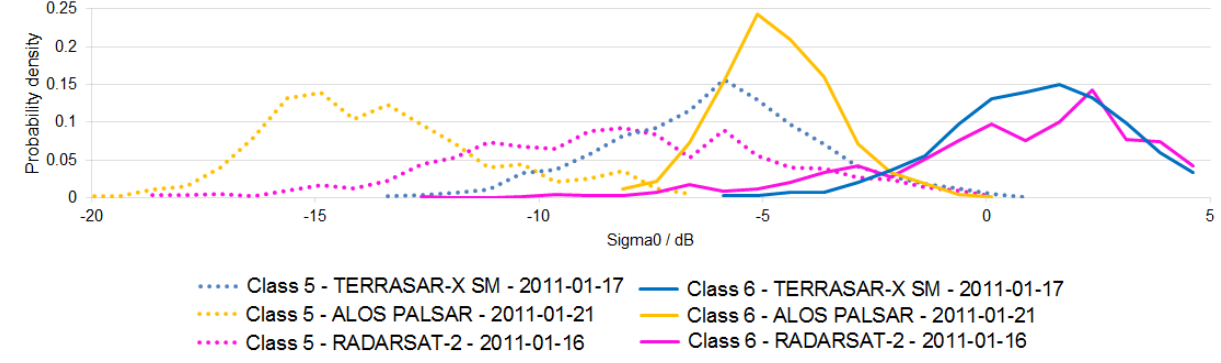
Figure 11. Histograms of class 2 and 3: TerraSAR-X SM (17 January 2011), ALOS PALSAR (21 January 2011), and RADARSAT-2 (16 January